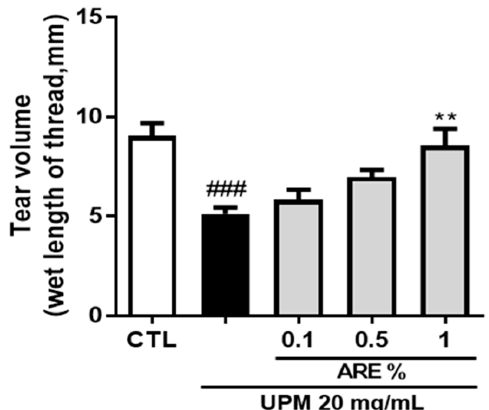
Figure 2. Achyranthis radix extract restored tear secretion in rat model of urban particulate matter- induced dry eye disease. The volume of tears secreted was measured using the phenol red thread test. The length of the thread that changed color to red is shown for each group. Each bar represents the mean tear volume ± SEM, n = 6. ### p < 0.001 vs. control group, ** p < 0.01 vs. UPM group. CTL, control; ARE, Achyranthis radix extract; UPM, urban particulate matter.